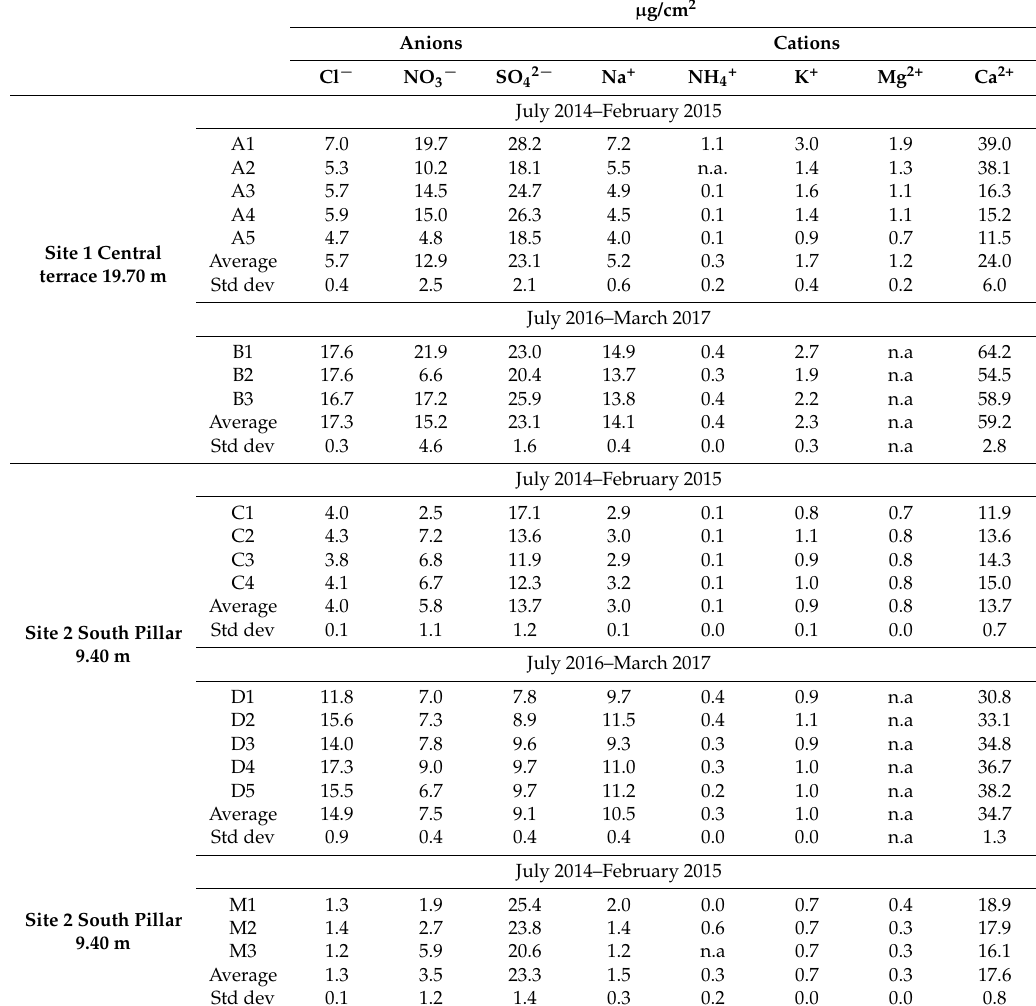
Table 2. Main ionic species determined on quartz fiber filters and powder deposits on marble specimens exposed in the two sites on the Duomo façade for two periods. µ g/cm 2 Anions Cations Cl − NO 3 − SO 42 − Na + NH 4+ K + Mg 2+ Ca